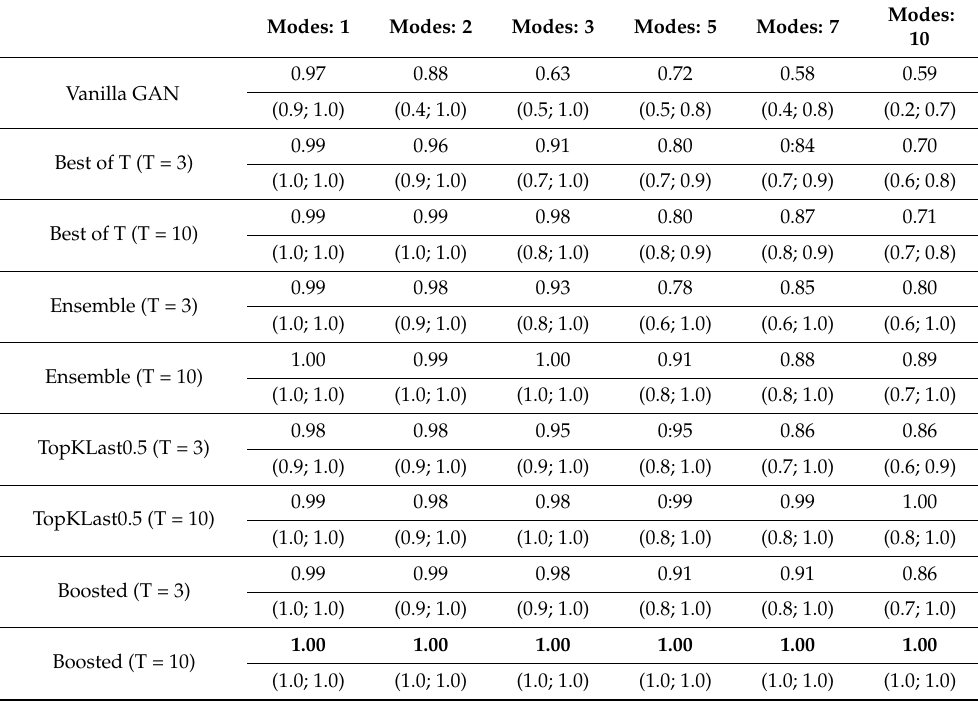
Table 7. Coverage score C for different